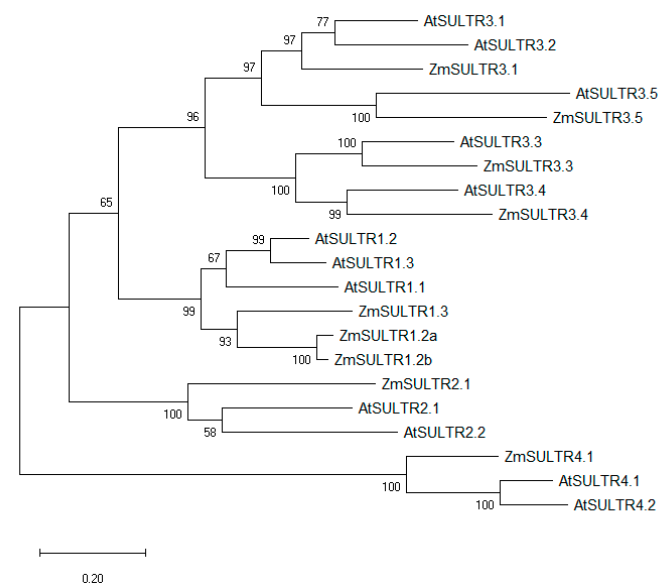
Figure 1. Evolutionary analysis by the maximum likelihood method among the protein sequences of the sulfate transporters of Arabidopsis thaliana and Zea mays . The evolutionary history was inferred by using the maximum likelihood method and the Jones-Taylor-Thornton (JTT) matrix-based model [19]. Evolutionary analyses were conducted in MEGA X [20].